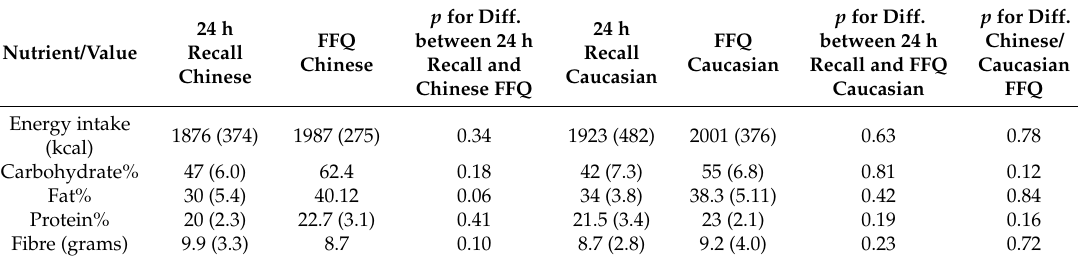
Table 2 Chinese/Caucasian FFQ and 24 h recall. Table 2. Dietary assessment within and between